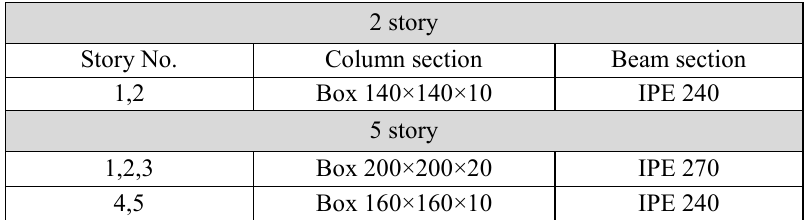
Characteristics of frames sections.